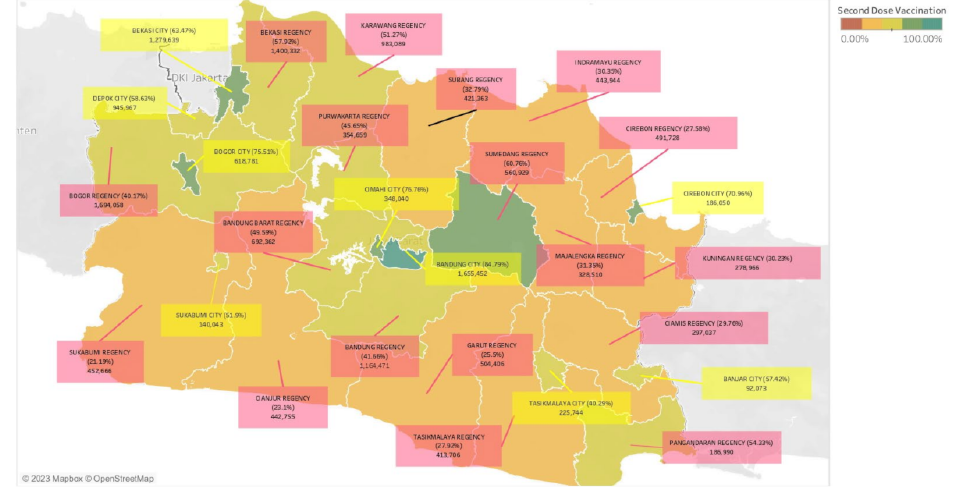
Figure 2. Total of second dose COVID-19 vaccination number and vaccination coverage in West Java as of 23 November 2021. The map color represents vaccination coverage and the box color represents regional status; pink for regency areas and yellow for city areas. A statistical test was carried out to analyze the significant difference in vaccination numbers and vaccination coverage between the city and the regency. The result of the Saphiro – Wilk normality test has shown that the vaccination number data in the two regions are not normally distributed ( p < 0.05), whereas vaccination coverage data are normally distributed ( p > 0.05). The statistical test used in Tables 2 and 3 is adjusted to the result of the normality